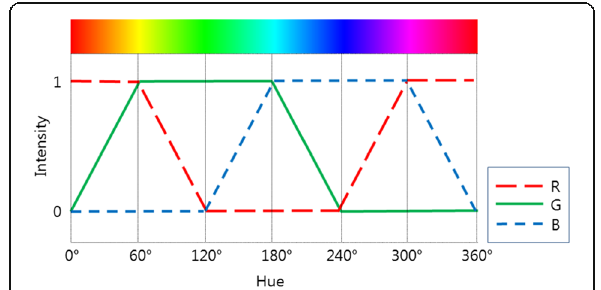
Fig. 2 The relationship between RGB values and hue